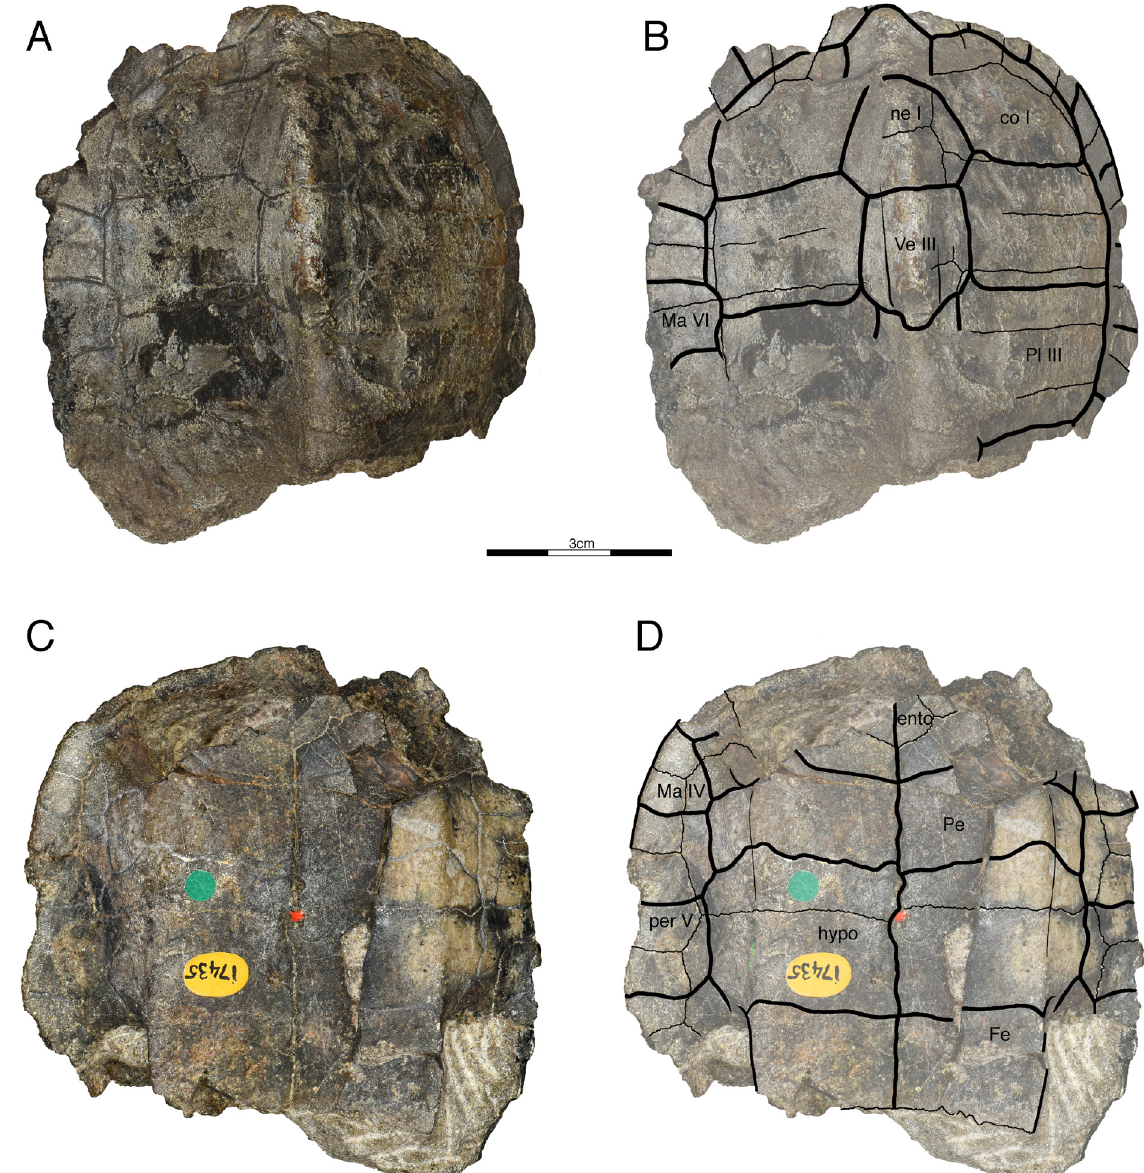
Fig. 17. BMNH 17435, referred to Pangshura sp. by Lydekker (1885a), herein confirmed. A . Photograph of carapace. B . Illustration of carapace. C . Photograph of plastron. D . Illustration of plastron. Scale bar: 3